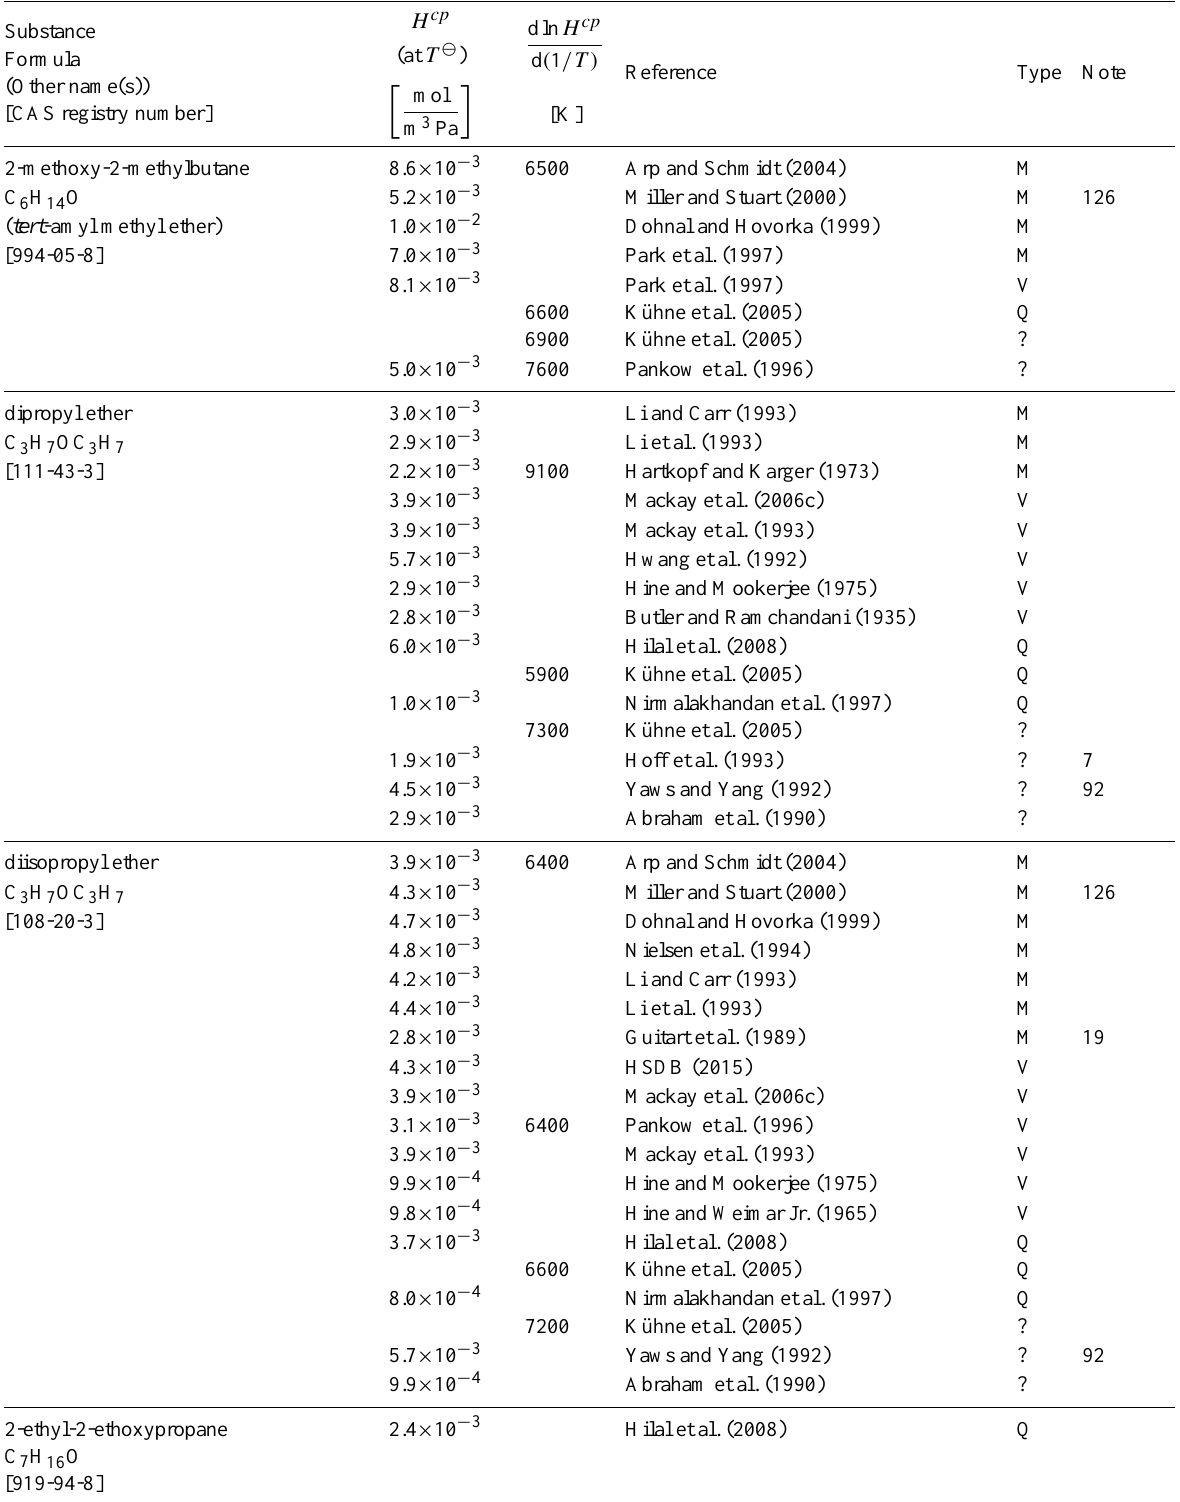
Table 6: Henry’s law constants for water as solvent